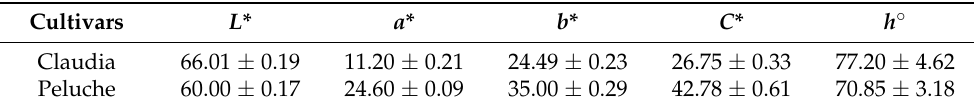
Table 1. Values of CIE L * a * b * coordinates measuring both cultivars, with values of chroma and hue angle (lightness ( L *); redness ( a *); yellowness ( b *); chroma ( C *); hue angle ( h ). Data correspond to the means ±